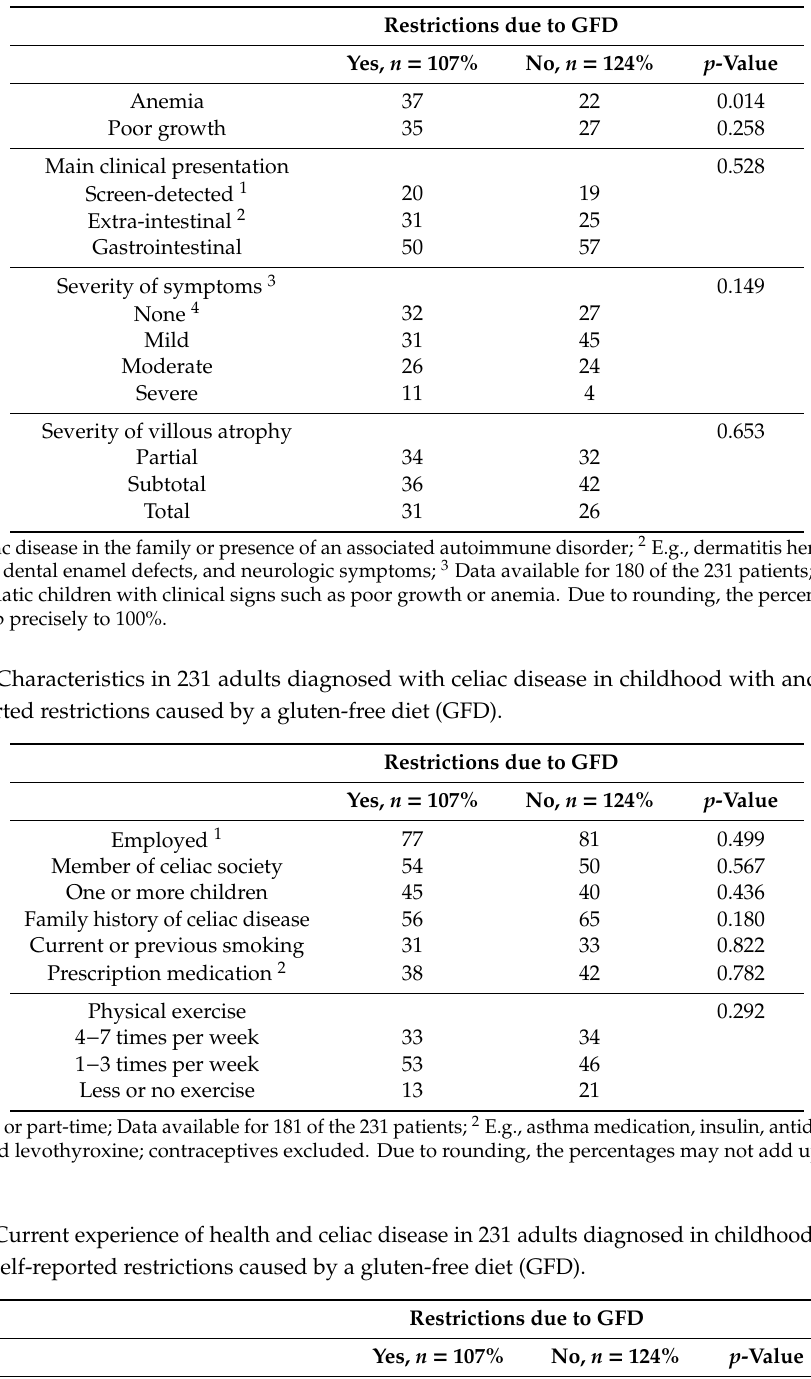
Table 1. Clinical characteristics of 231 children upon celiac disease diagnosis with and without later self-reported restrictions caused by a gluten-free diet (GFD) in adulthood.